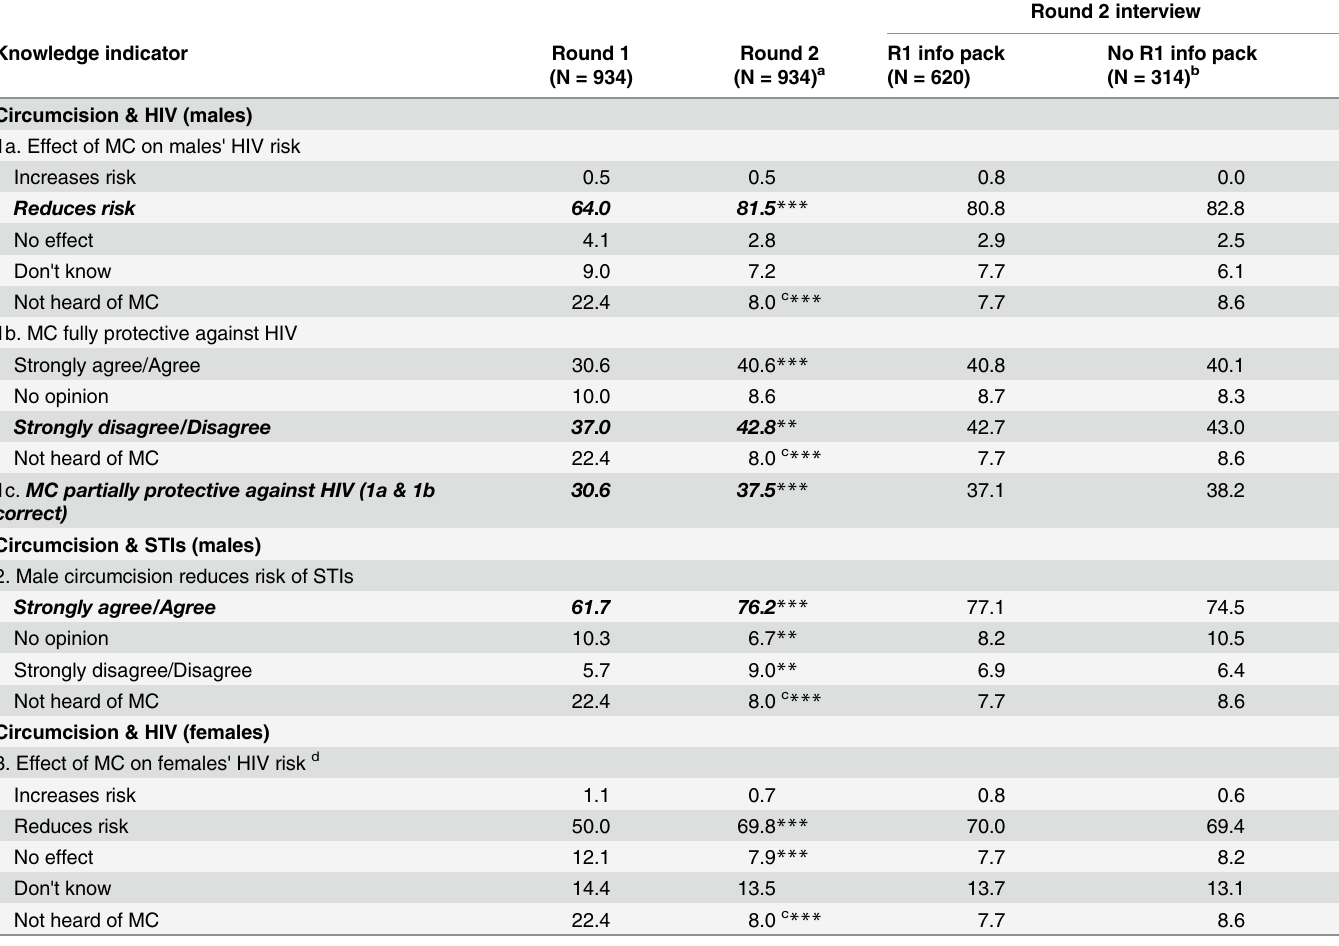
Table 2. Knowledge of male circumcision (MC) and its protective benefits among women interviewed in Round 1 and Round